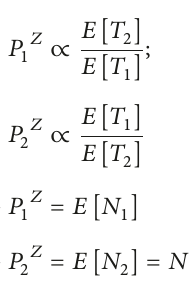
Figure 2: Two cases with the traffic flow. the number of drivers entering each route within circle time 𝜏 .